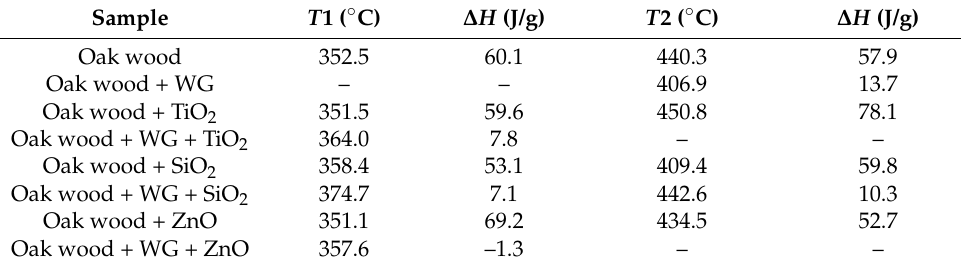
Table 2. Peak temperatures and enthalpy obtained from DSC curves.